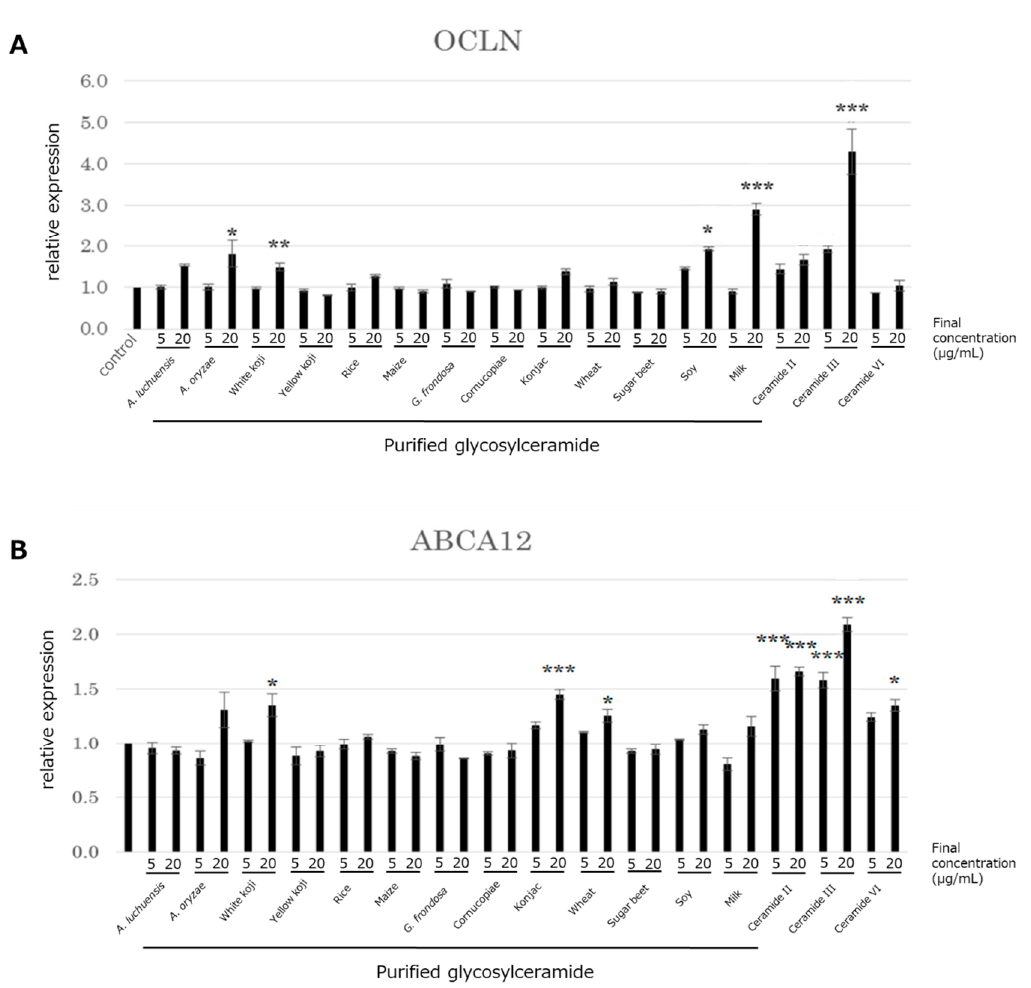
Figure 4. Expression of the OCLN and ABCA12 genes in NHEK cells upon addition of various glycosylceramides and ceramides. Glycosylceramides and ceramides were incubated with NHEK cells, whereupon the total RNA was extracted and the expression of ( A ) OCLN and ( B ) ABCA12 were analysed by real-time PCR. The values on the x-axis indicate the final concentrations of sphingolipids ( µ g / mL) added ( n = 3, Dunnett’s test, *, p < 0.05; **, p < 0.01; ***, p <